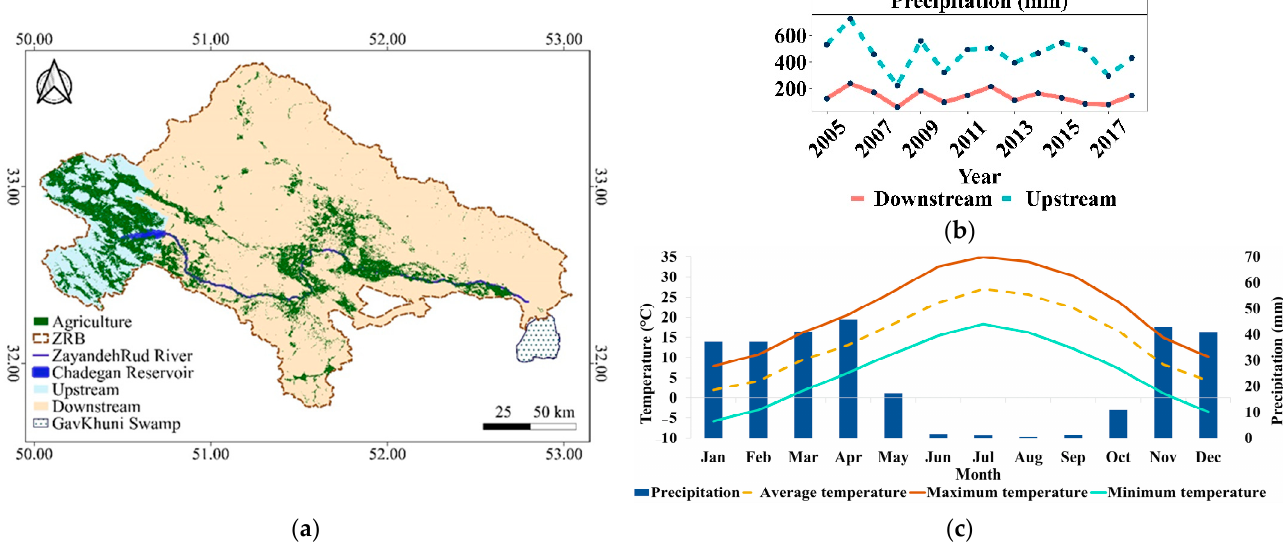
Figure 1. ( a ) The Zayandehrud River basin (ZRB), ( b ) Annual average precipitation upstream and downstream of the ZRB, ( c ) Climograph of the ZRB: Long-term monthly average precipitation and temperature.